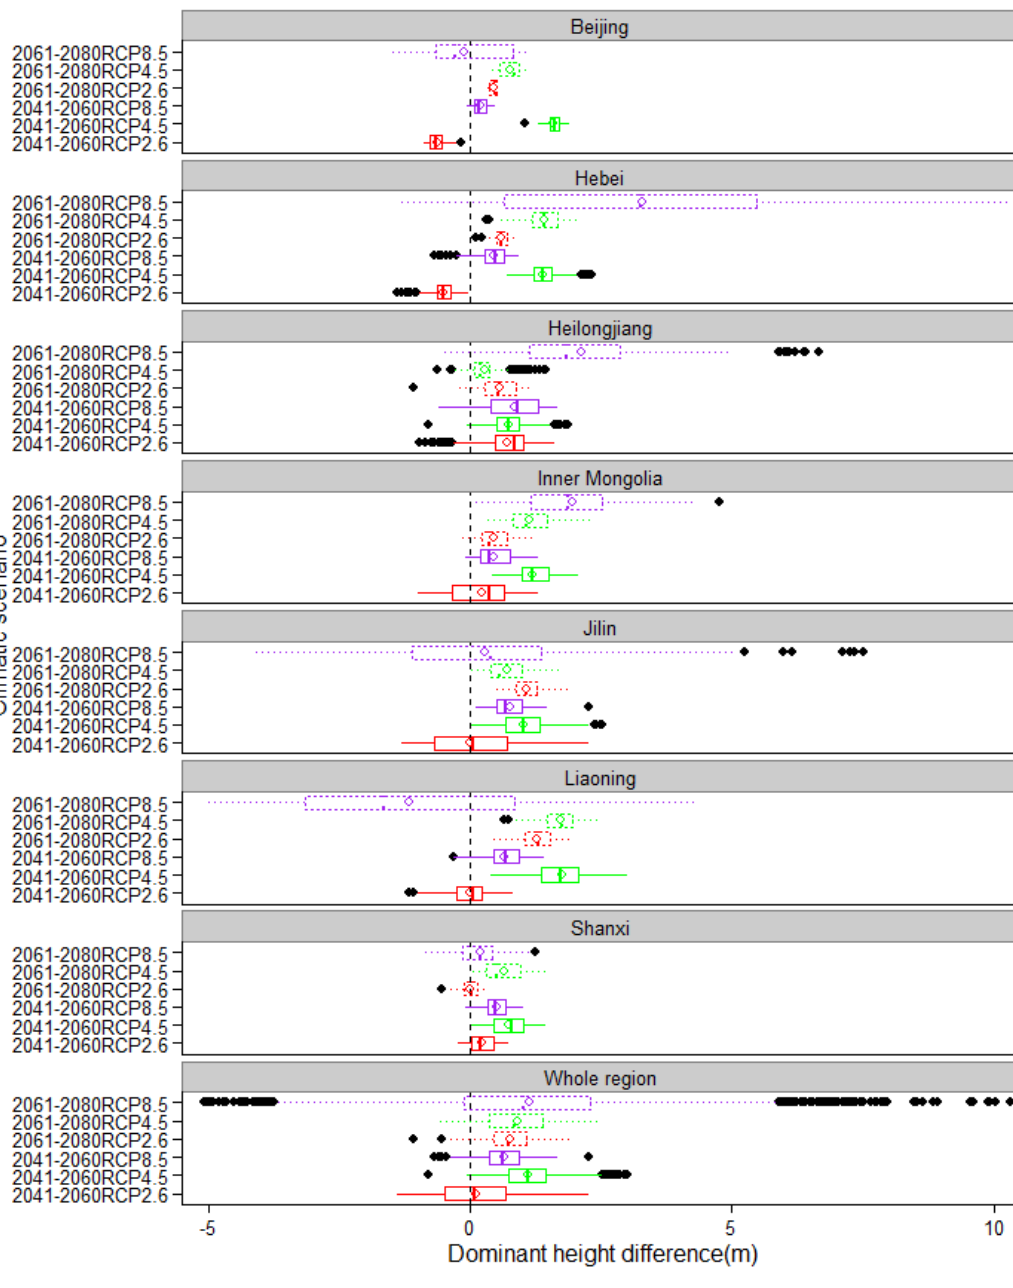
Figure 3. Boxplot of the predicted dominant height difference between different climate scenarios and current climate for seven provinces and the whole region; the hollow circles in each bar indicate the average values; the dashed vertical lines show zero lines (no dominant height difference). 232